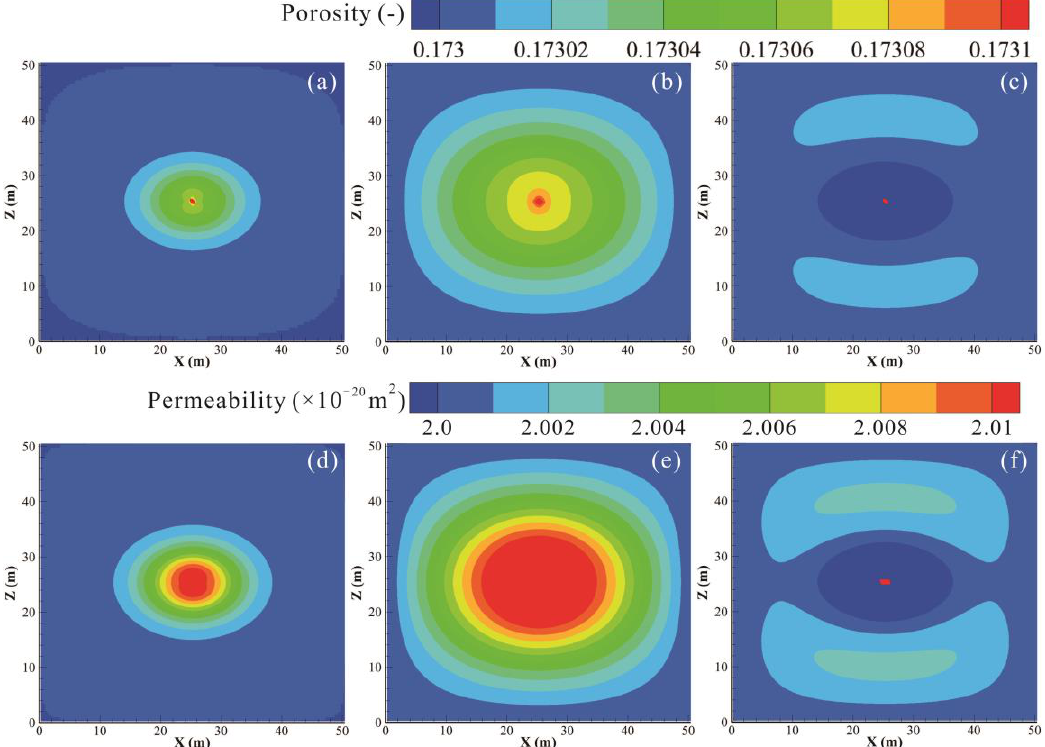
Figure 18. Spatial distributions of model predicted porosity at ( a ) 938.5 days, ( b ) 2763.5 days, ( c ) 4588.5 days, and permeability at ( d ) 938.5 days, ( e ) 2763.5 days, and ( f ) 4588.5 days.